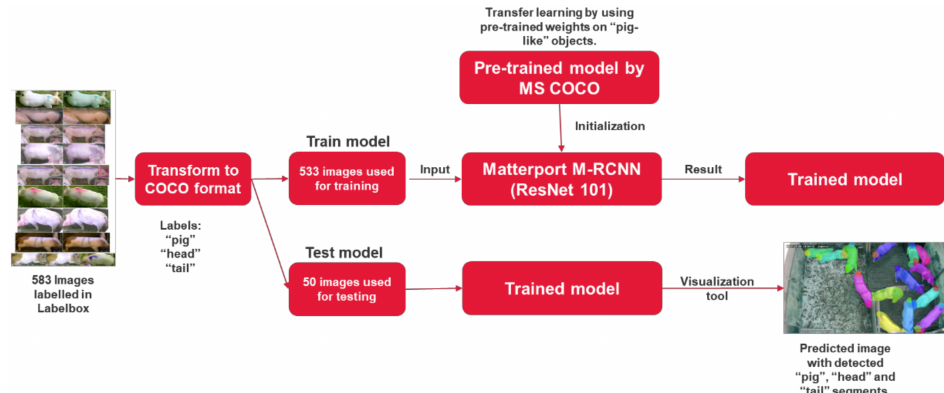
Figure 5. The Digital Pig Matterport M-RCNN-based segmentation framework